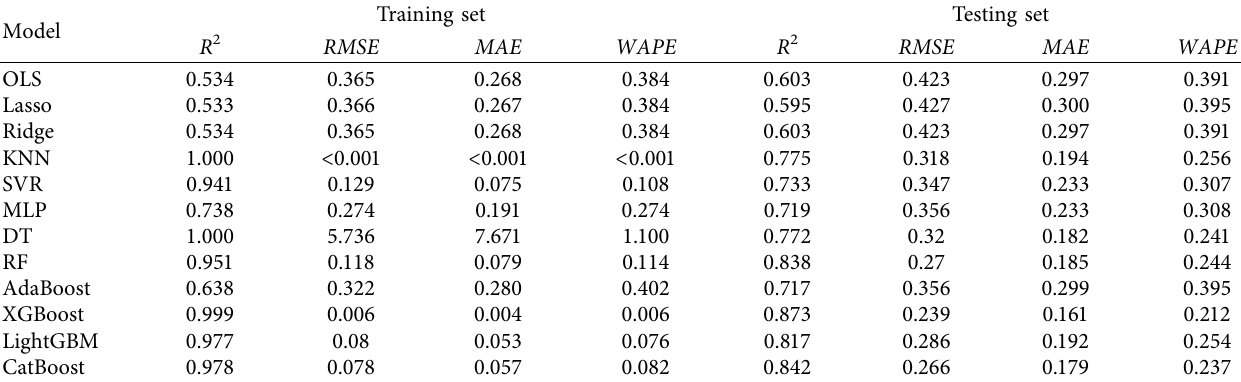
Table 3: Performance measure of the developed models.